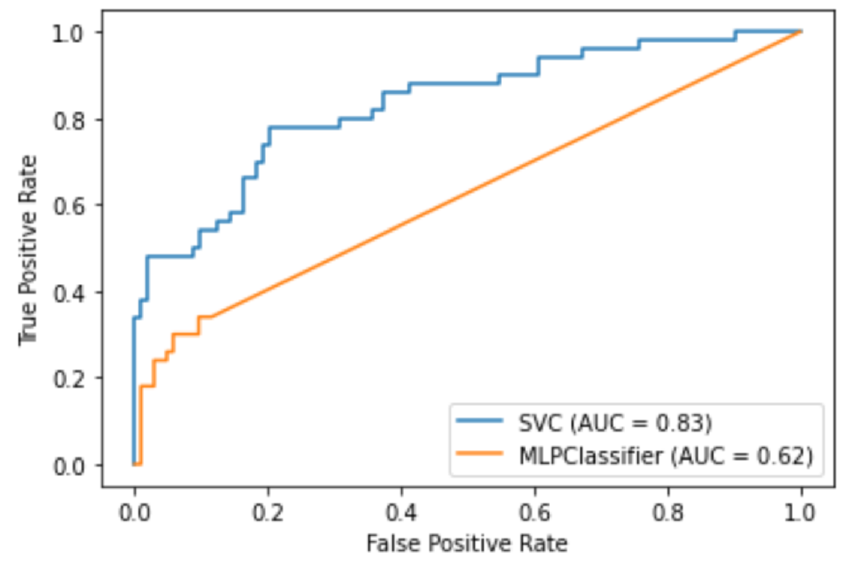
Figure 3. ROC curve for SVM and MLP